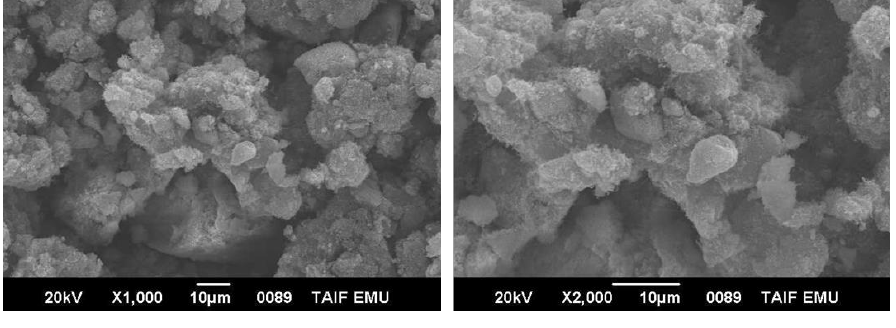
Figure 8. IR spectrum of the ZnFe 2 O 4 -CNT adsorbent.